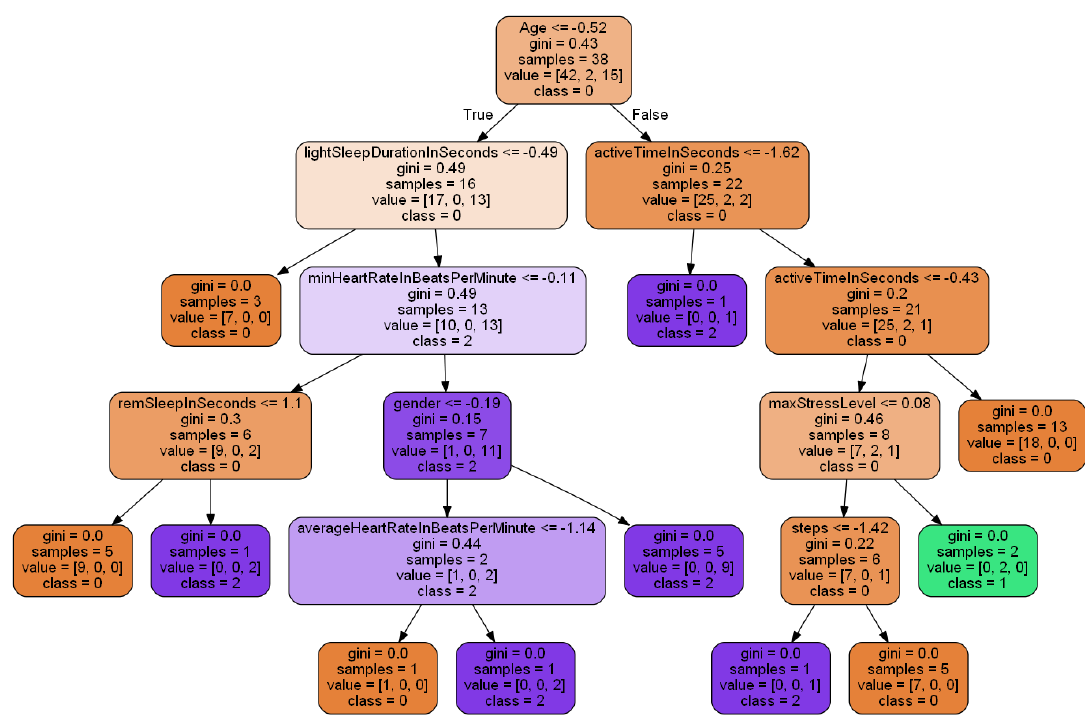
Figure 12. Best Tree.